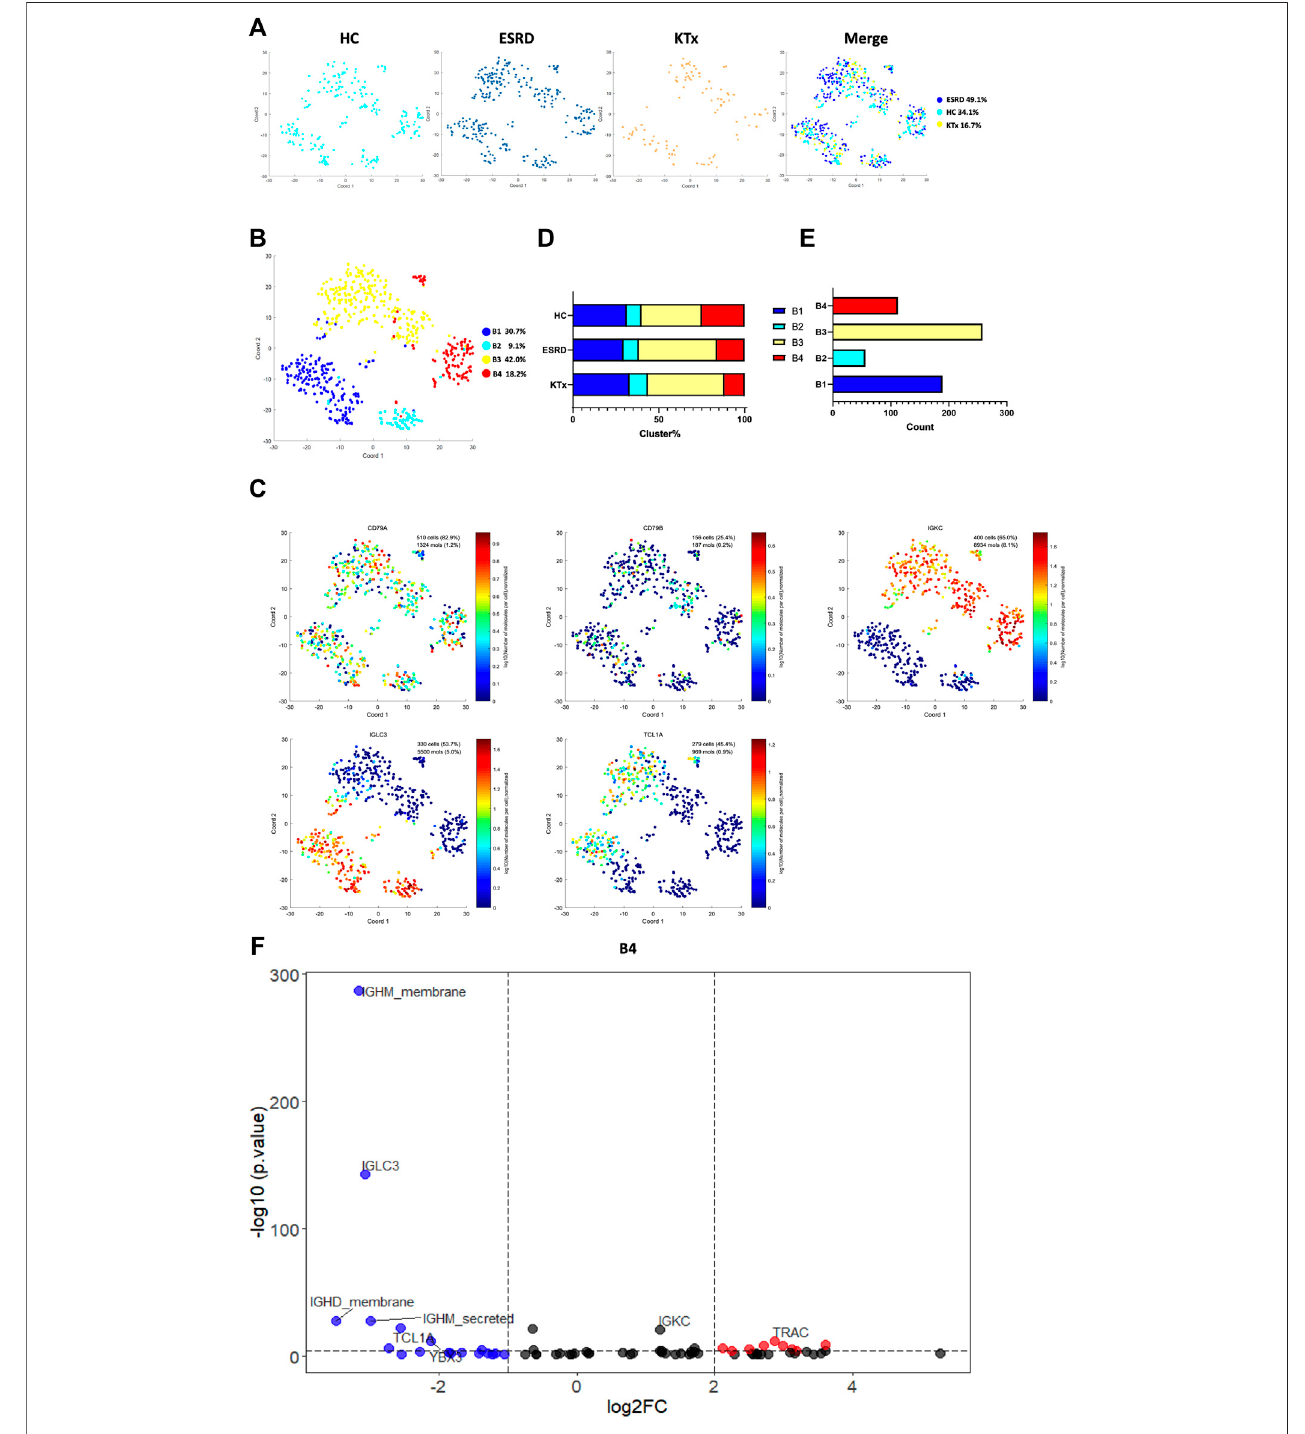
FIGURE 5 | B-cell clusters in PBMCs from HC, ESRD, and KTx. (A,B) tSNE of single-cell pro fi le with each cell color coded for B-cell subsets. (C) Expression of highly expressed genes in each B-cell cluster. (D) Distribution of 5 B-cell subsets. (E) Cell count of 4 B-cell subsets. (F) Gene fi ngerprint expression volcano map of B4